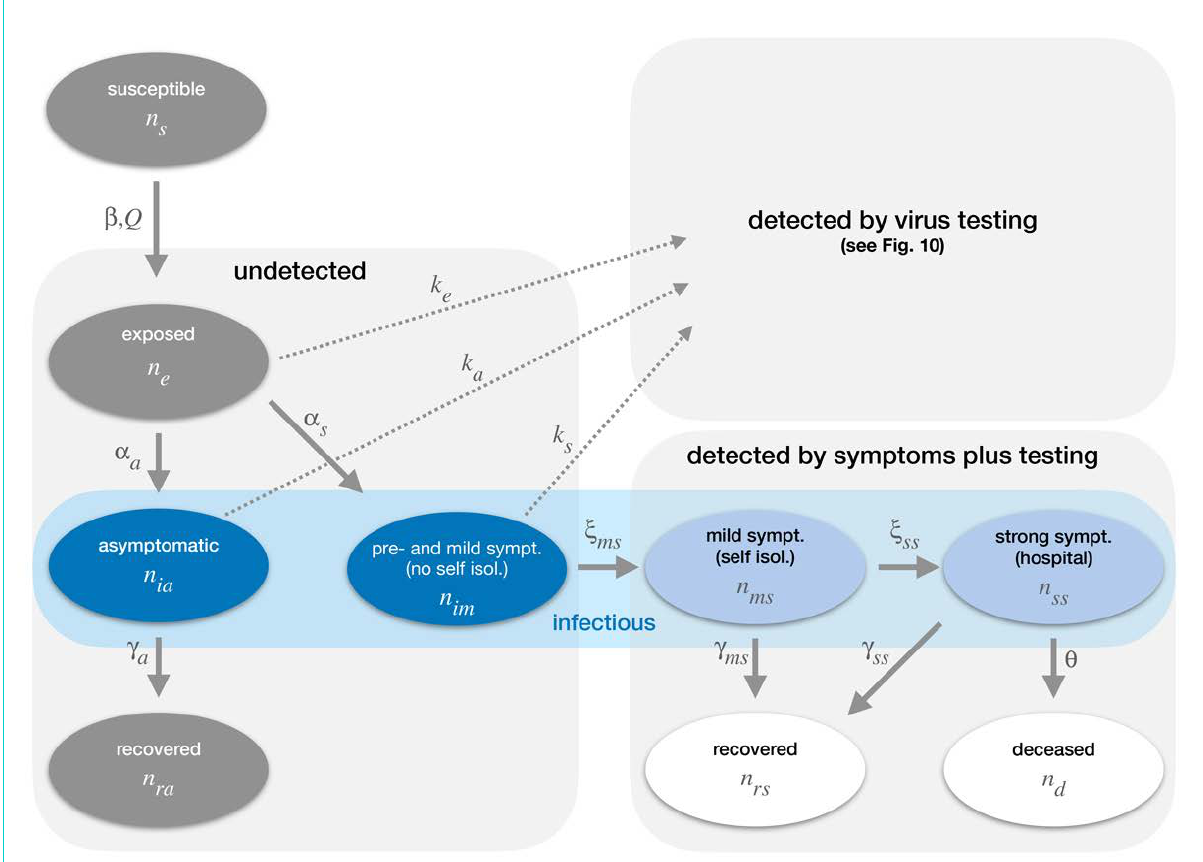
Figure 1: Graphical representation of the model. The graph showing the dependencies of the compartments describing the transmission dynamics among susceptible